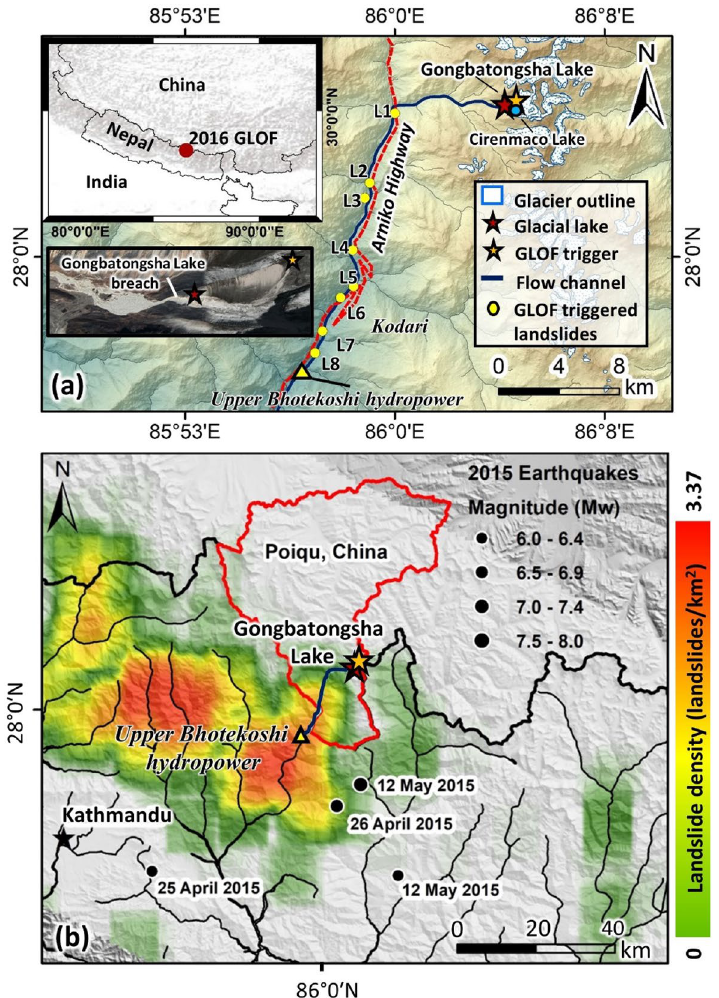
Figure 1. ( a ) Location of the study area showing the Gongbatongsha Lake and the location of the debris flow that triggered the GLOF; marked are the locations of the mapped GLOF induced landslides and the Upper Bhotekoshi hydropower plant; ( b ) Earthquake-induced landslide density map using data from Kagel et al. 29 . Also shown are the (≥ M6) epicenters of major Gorkha earthquake aftershocks. The mainshock was west of this figure. Red outlines the boundary of the Poiqu basin, and blue marks the debris flow channel. This map was generated using ArcMap 10.8 software (© ESRI, https:// deskt op. arcgis. com). Subset in panel a is from Google Earth (©CNES/Airbus Maxar